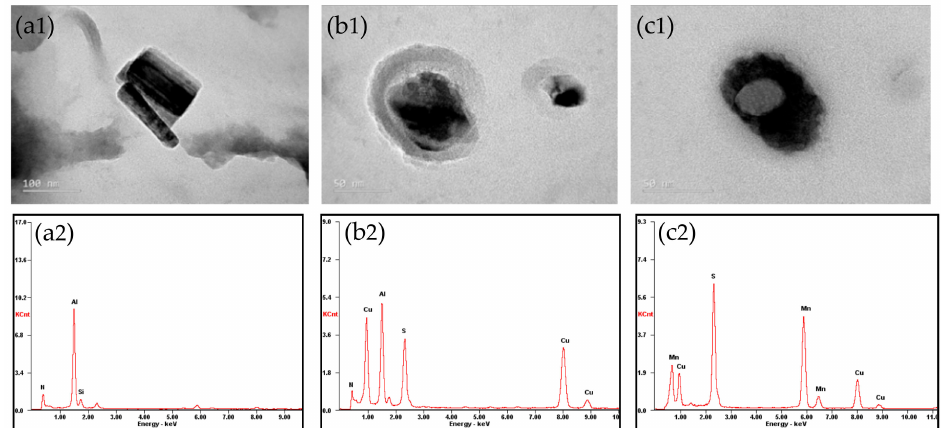
Figure 6. Typical morphologies and EDS results of precipitates in a decarburized sheet observed by TEM: ( a1 , a2 ) AlN; ( b1 , b2 ) AlN + Cu x S; and ( c1 , c2 ) (Mn,Cu)S.